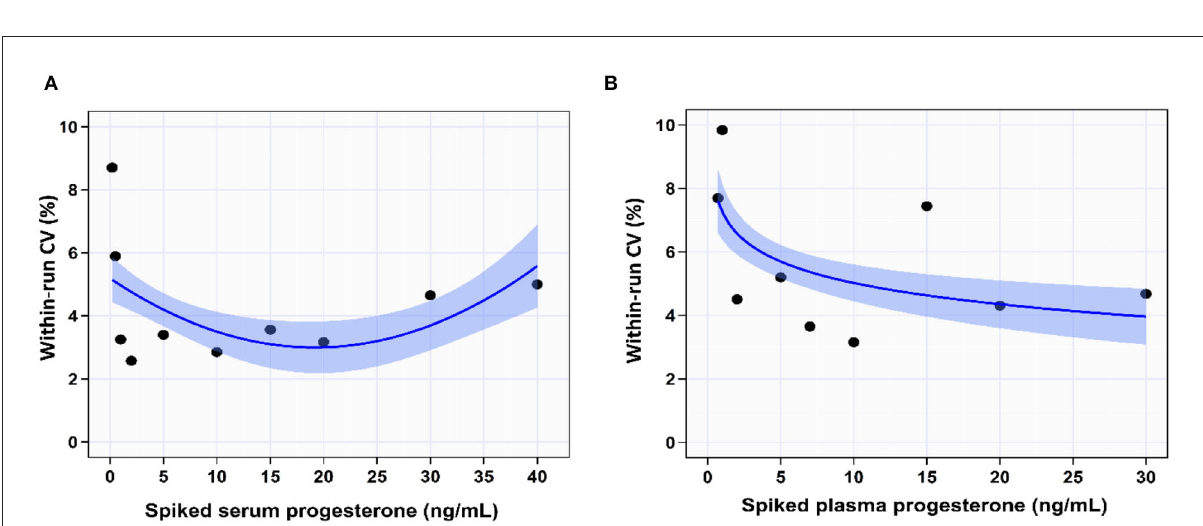
FIGURE2 The coefficient of variation percentage (CV%) indicated the within-run precision of IMMULITE ® 2000 XPi P4 immunoassay across the spiked serum (A) and plasma (B) progesterone concentrations. The solid blue lines are the best-fit regression lines. The light blue shaded areas indicate the 95% confidence bands for the regression lines.